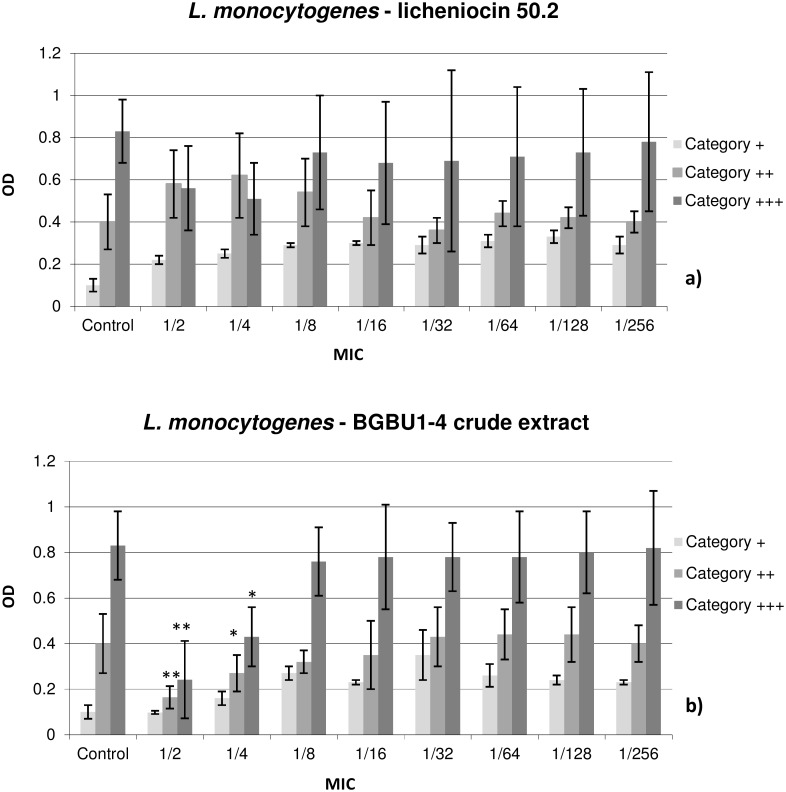
The effect of lichenocin 50.2 and BGBU1-4 crude extract on biofilm formation of L. Monocytogenes.The effect of subinhibitory concentrations (1/2–1/256 X MIC) of lichenocin 50.2 (2a) and BGBU1-4 crude extract (2b) on biofilm formation of L. monocytogenes. Results are presented as mean OD ± standard deviation; Category +, weak biofilm producer; Category ++, moderate biofilm producer; Category +++, strong biofilm producer; * p<0.05, ** p<0.01. Control–biofilm density of bacteria cultivated in medium without presence of bacteriocins.